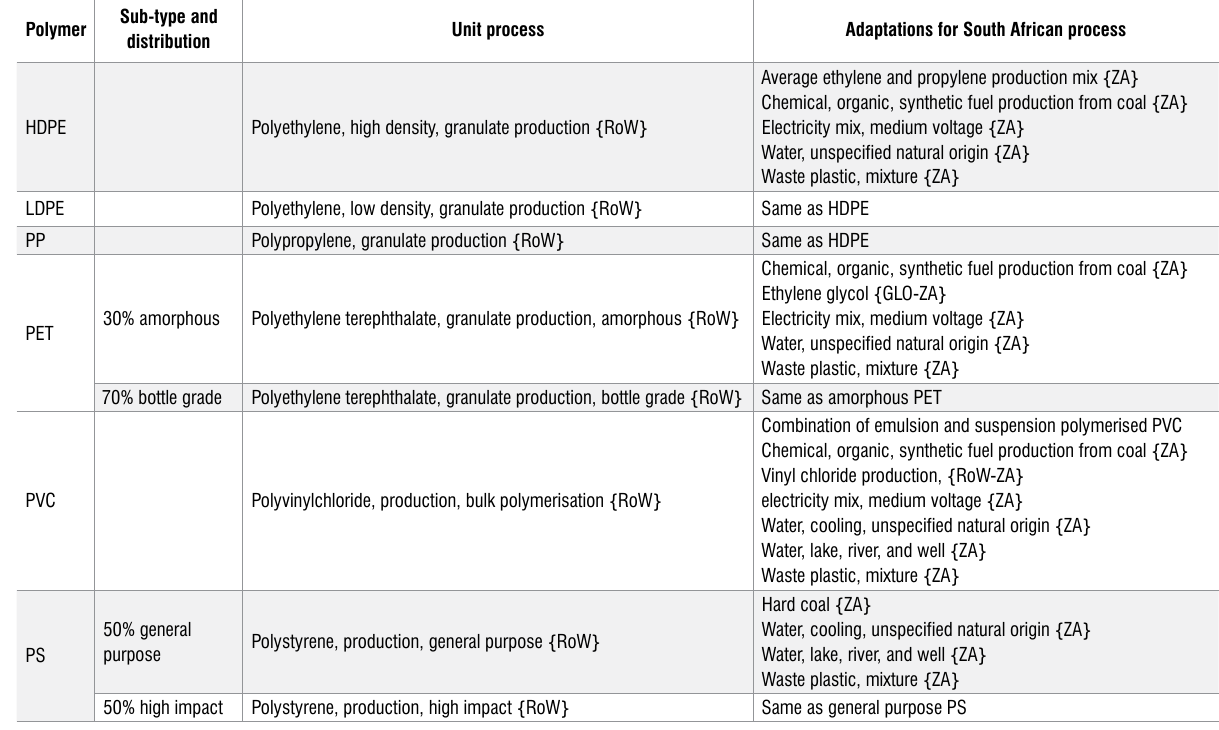
Table 1: Data source, distribution, and adaptations for resin production processes